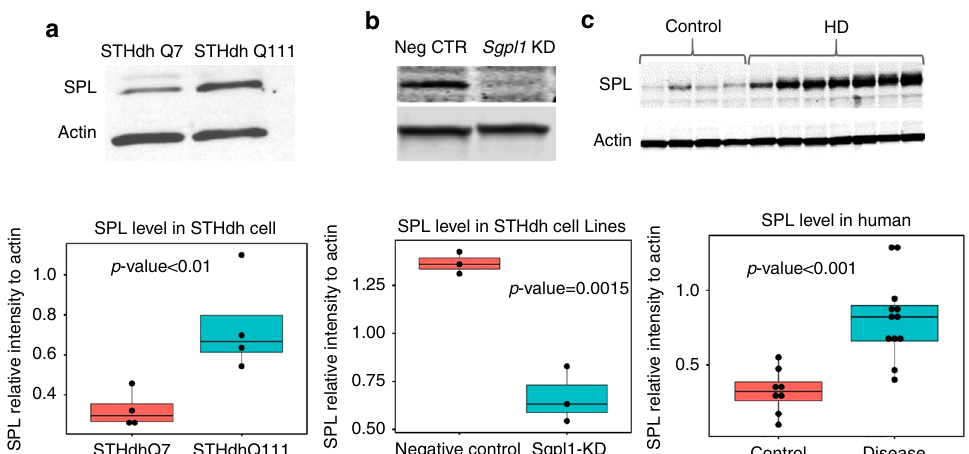
Fig. 4 SPL enzyme is signi fi cantly upregulated in HD. a Western blot results indicate that SPL levels are signi fi cantly higher in STHdh Q111 cells compared to STHdh Q7 cells ( p < 0.01, two-tailed t -test, 4 replicates). b Western blot experiments show a signi fi cant decrease in the Sgpl1 -encoded protein after the knock-down experiments ( p = 0.0015, two-tailed t -test, 3 replicates). The plot shows the levels of Sgpl -1 encoded protein. siRNA-mediated knock-down experiments were performed to validate the speci fi city of the SPL antibody (Abcam, ab56183): STHdh Q111 cells treated with siRNA against Sgpl1 ( Sgpl1 KD) showed a drop in the signal compared to STHdh Q111 cells treated with negative control siRNA (Neg CTR). c Western blot analyses reveal that SPL enzyme levels are signi fi cantly upregulated ( p < 0.001, two-tailed t -test, 8 control, and 12 HD samples) in postmortem cortical tissues of HD brain compared to controls. The boxplots represent the distribution of the ratios of SPL to actin levels, in which the fi rst and the third quartiles of the data are displayed by the top and the bottoms of respective boxes and the median (second quartile value) is show as a horizontal line within the